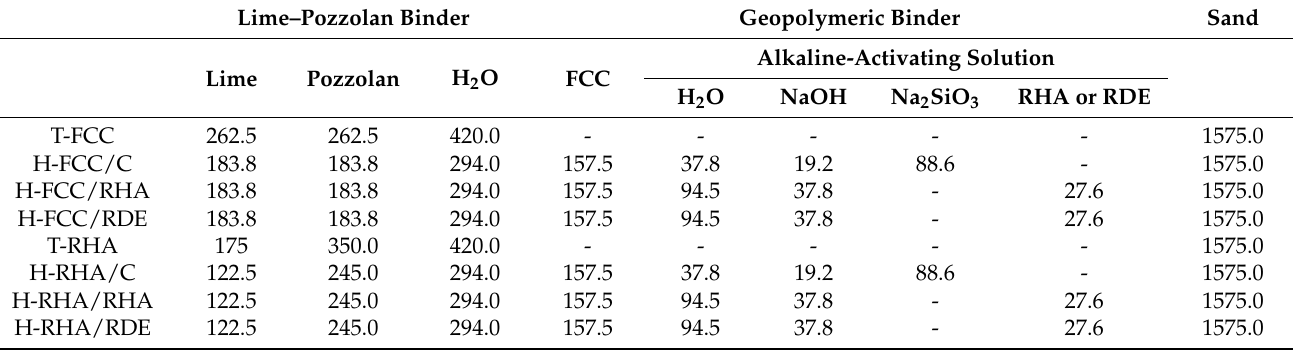
Table 2. Mix proportions of traditional and hybrid mortars .